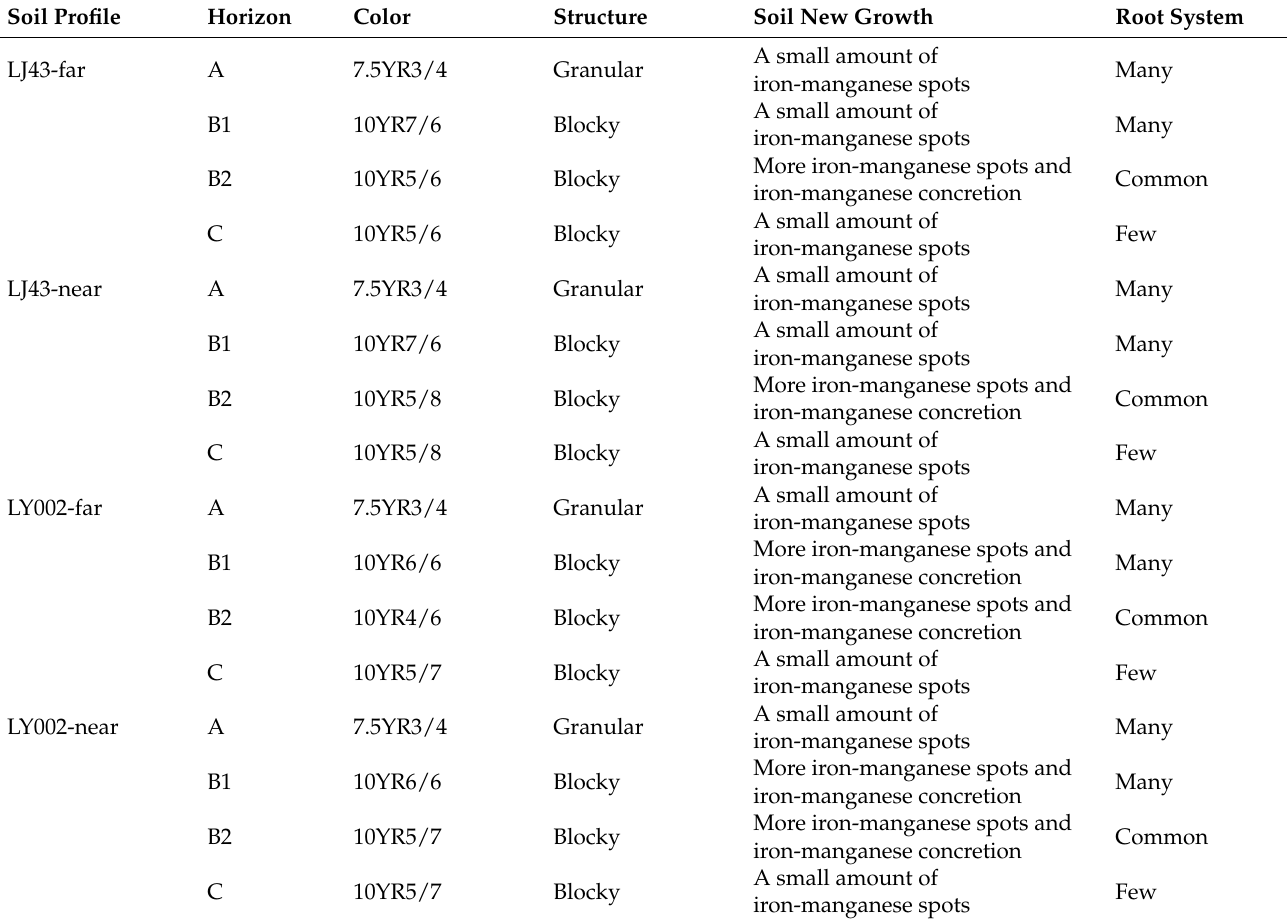
Table 3. Description of soil profile morphology in Yunqi Zhujing, Hangzhou,